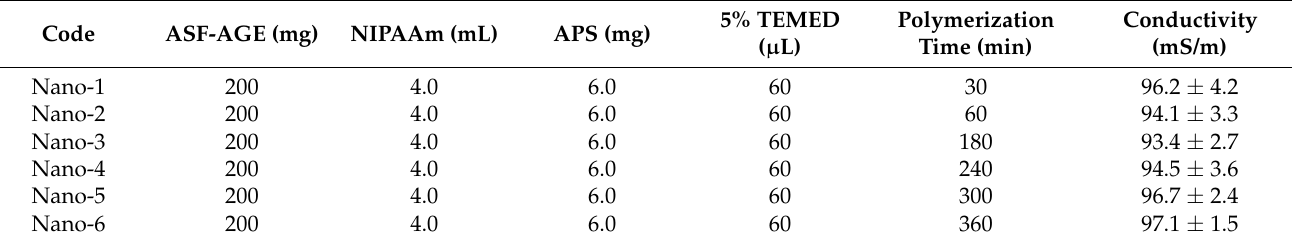
Table 1. The formulation of p (ASF-AGE-NIPAAm) spinning